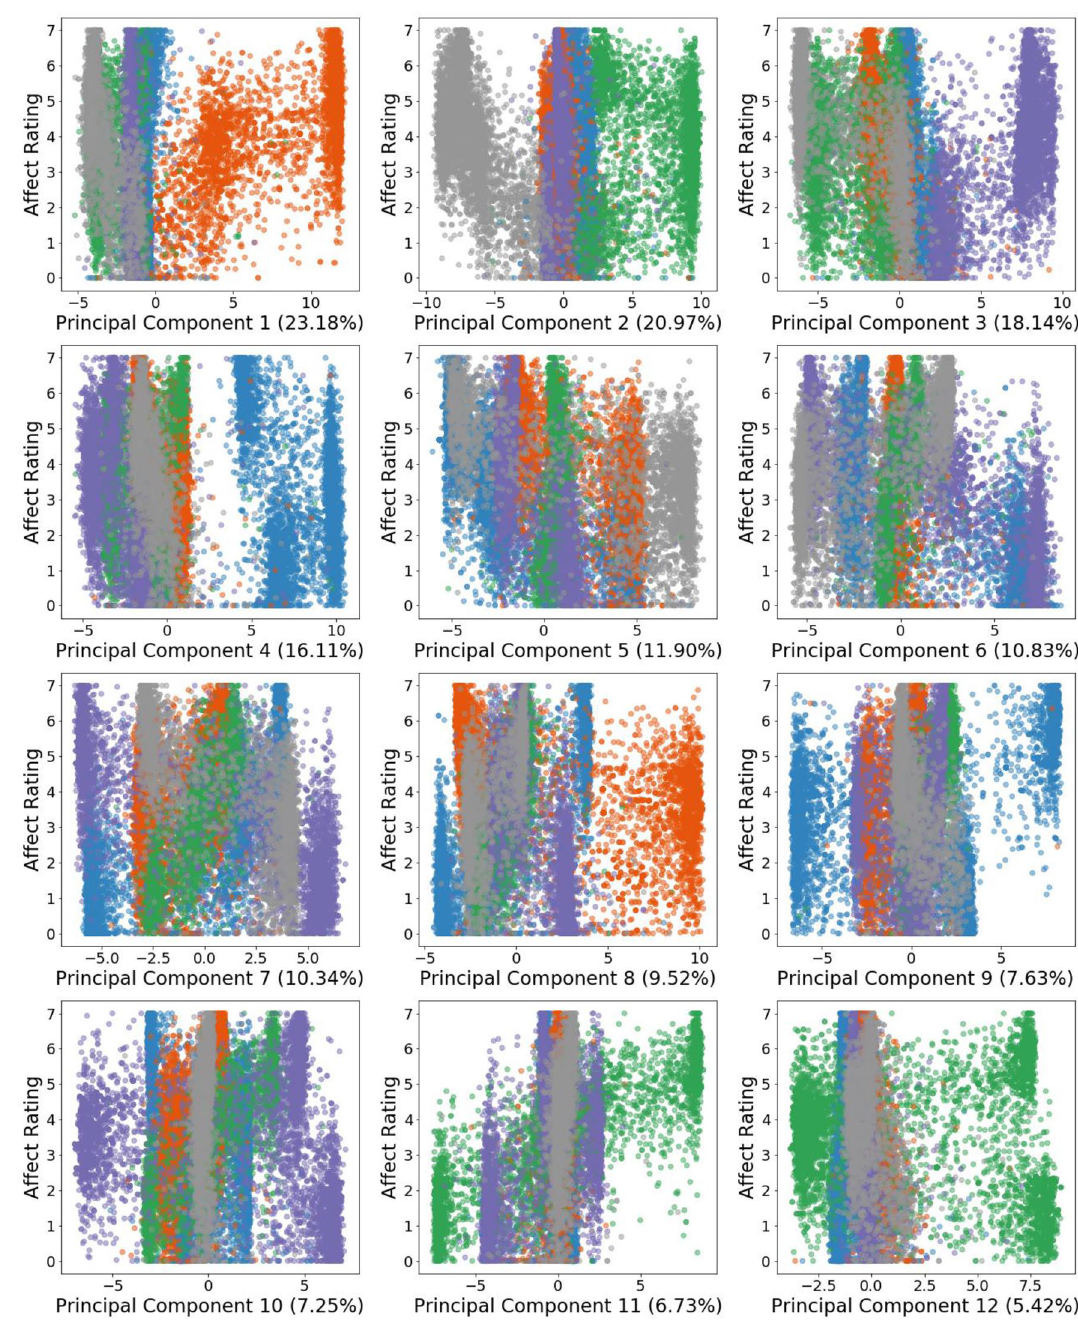
Figure 1. Scatterplots for each of the first twelve principal components (PC) ranked by explained variance (in brackets), from all fine-tuned RoBERTa embeddings. Each subplot plots the projected PC scores on the x-axis against their corresponding emotion ratings on the y-axis. Every observation is colour-coded by emotion, with orange representing embarrassment stories, grey for sadness stories, green for joy, purple for risk, and blue for disgust